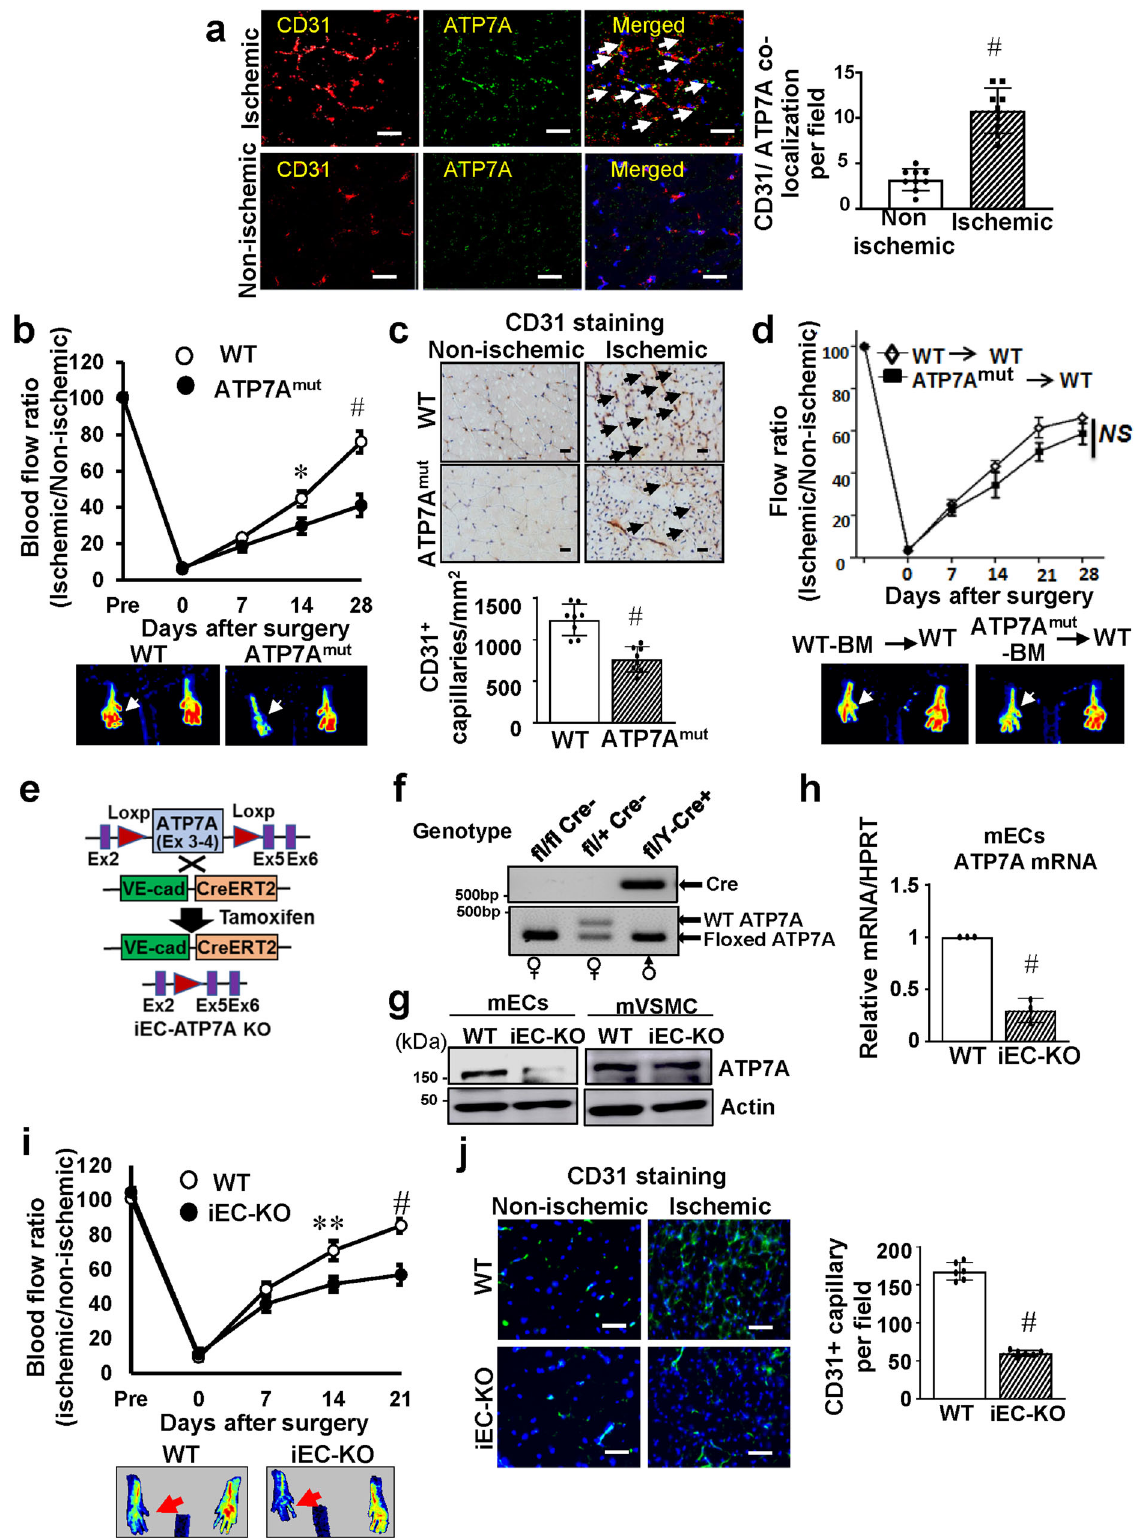
ATP7A knockdown in ECs inhibits VEGFR2 signaling via promotion of VEGFR2 degradation in a Cu-independent manner . We next examined the role of ATP7A in VEGF-induced angiogenic responses in primary cultured ECs. Figure 2a, b, using the modi fi ed Boyden chamber assay, showed that VEGF-induced EC migration was signi fi cantly inhibited in ECs isolated from